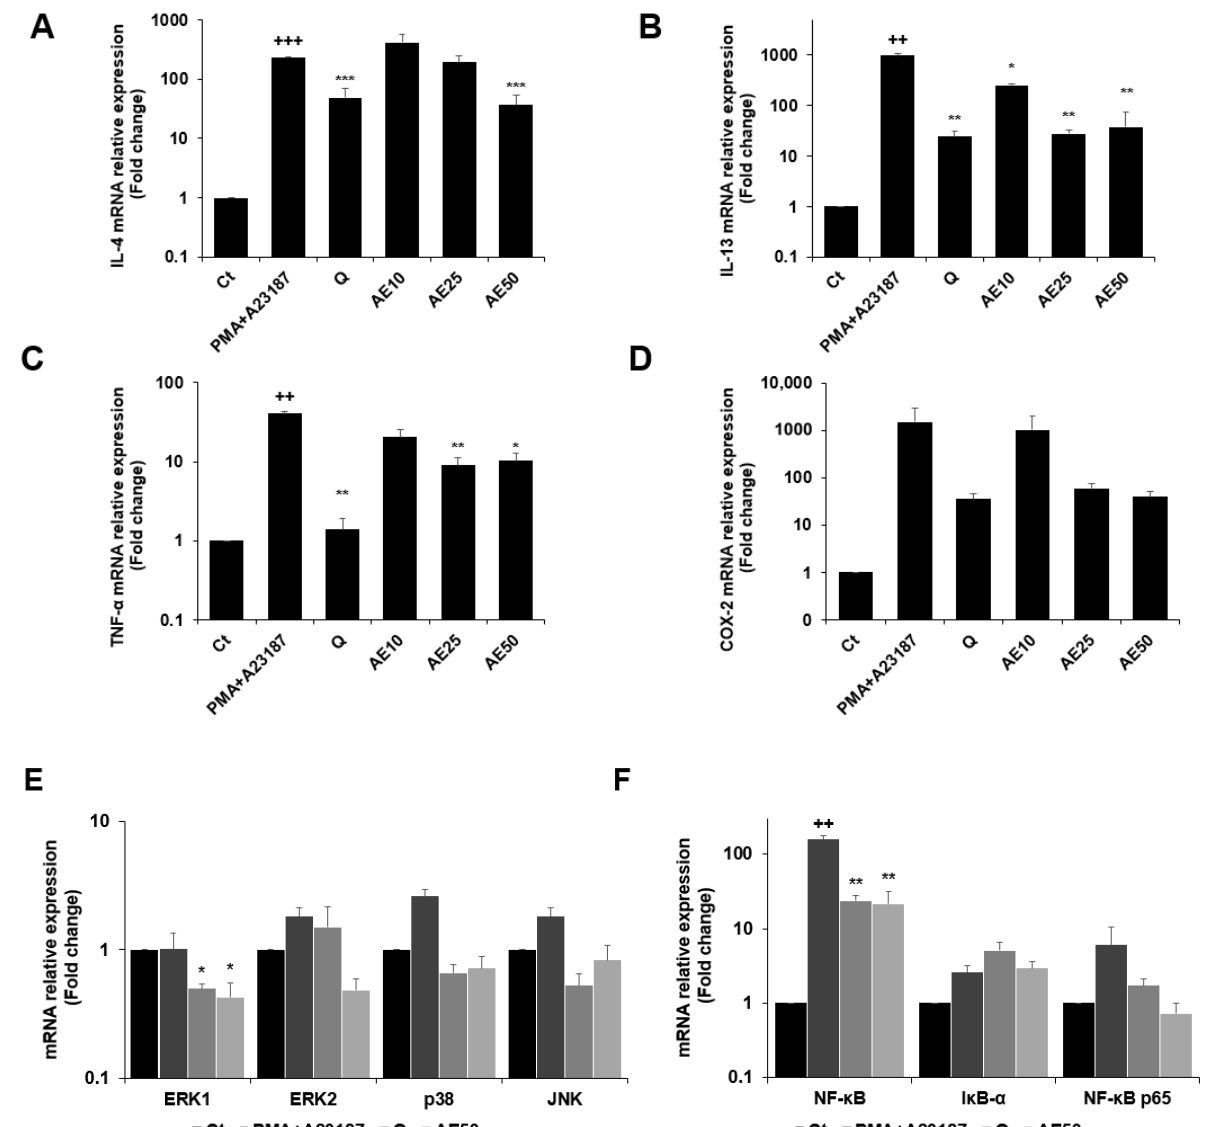
Figure 6. Effects of the amber extract on cytokine-, MAPK-, and NF- κ B-related gene expressions of RBL-2H3 cells stimulated by PMA + A23187 for 4 h. ( A ) The mRNA expression levels of IL-4. ( B ) The mRNA expression levels of IL-13. ( C ) The mRNA expression levels of TNF- α . ( D ) The mRNA expression levels of COX-2. ( E ) The mRNA expression levels of ERK1/2, JNK, and p38. ( F ) The mRNA expression levels of NF- κ B, I κ B- α , and NF- κ B p65 were measured by qRT-PCR. Data are expressed as mean ± SEM (++ p < 0.01, +++ p < 0.001 vs. control; * p < 0.05, ** p < 0.01, *** p < 0.001 vs. PMA + A23187).